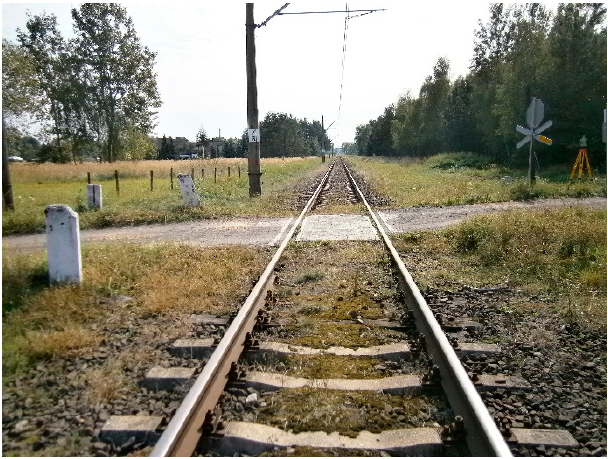
Figure 8. Railway level crossing no. 144 007 581 on a single-track railway line.